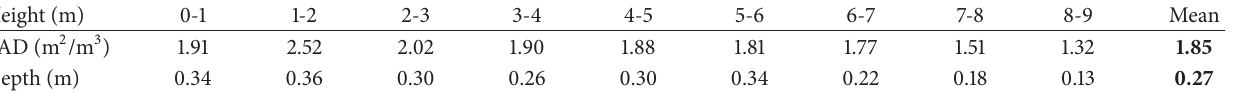
Table 1: Leaf area density (LAD) and depth of the fac¸ade greening based on a vertical transect of (1m × 9m).